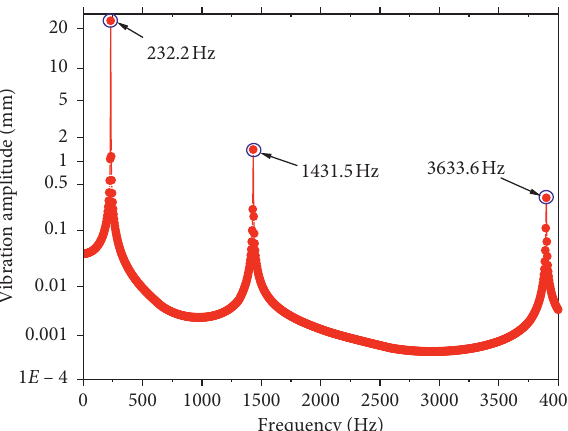
Figure 12: The inherent frequency of piezoelectric cantilever beam.